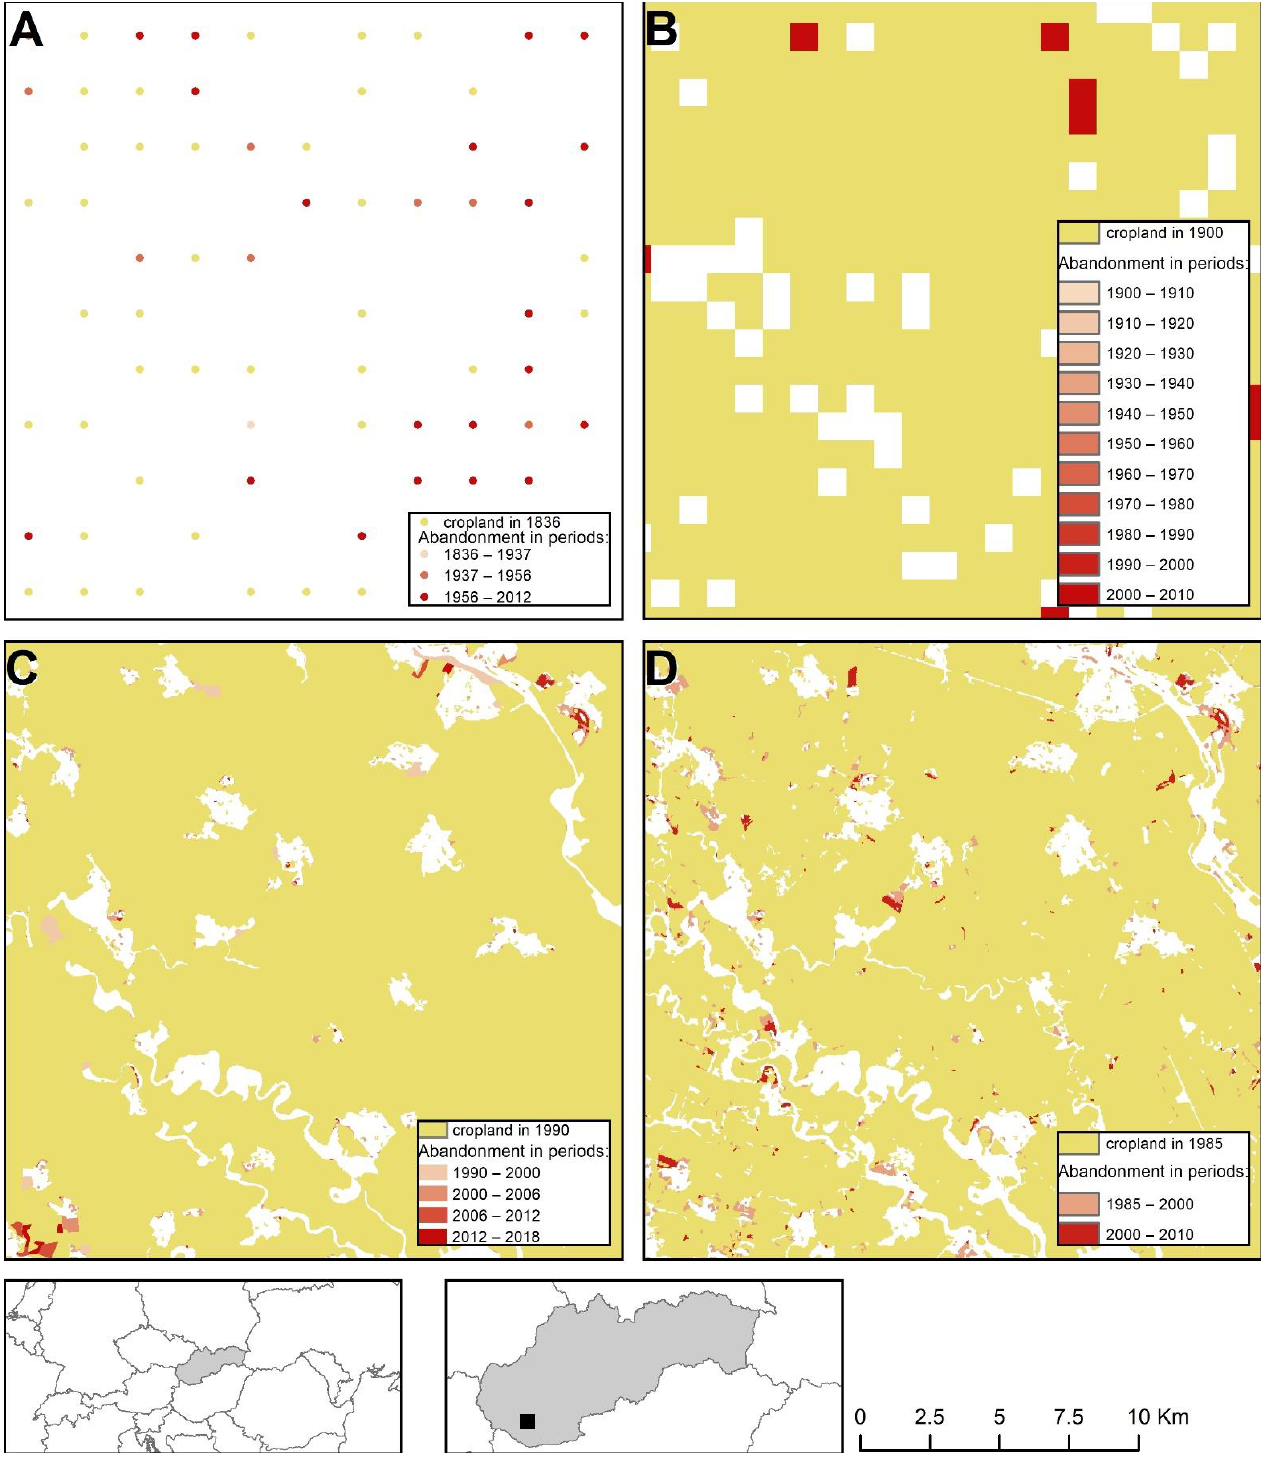
Figure 1. Selected area of the map of cropland abandonment rates visualised from four different data sources: ( A ) Carpathian Historical Land Use Dataset (CHLUD), ( B ) Historic Land Dynamics Assessment (HILDA), ( C ) CORINE Land Cover, and ( D ) Landsat dataset. Bottom maps: Area of Slovakia and selected region. Maps covering all of Slovakia are contained in Supplementary Figures S1–S4 .